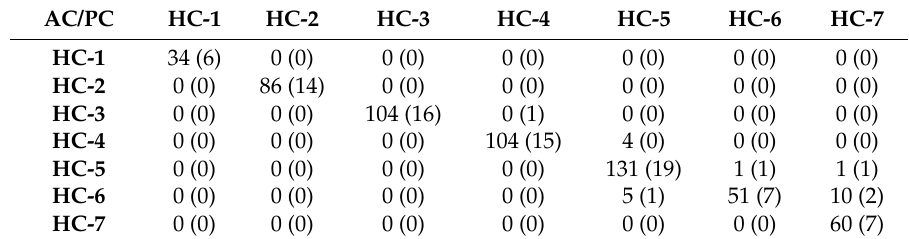
Table 7. Confusion matrix for training and testing data of ANFIS with triangular MF and a linear function.